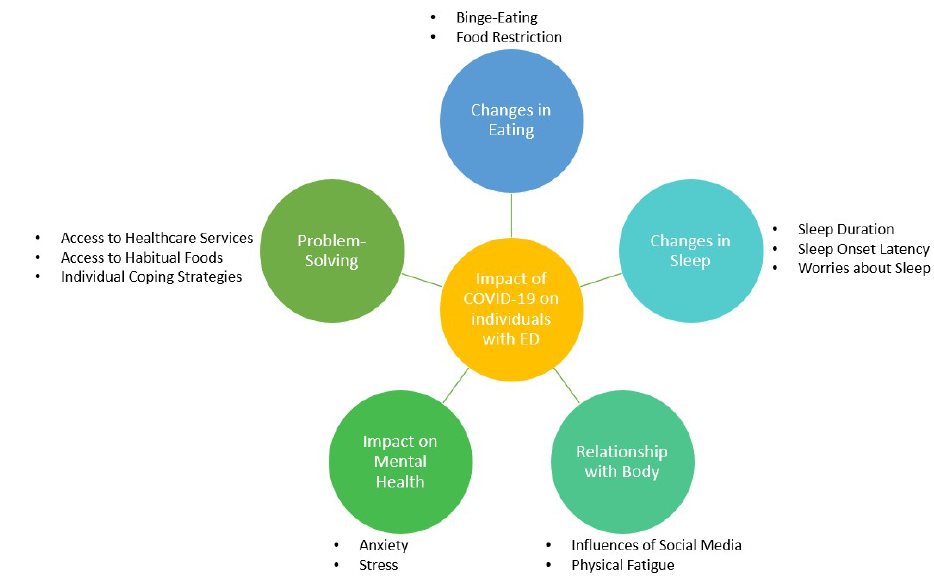
Figure 1. Thematic network of the impact of COVID-19 on individuals with eating